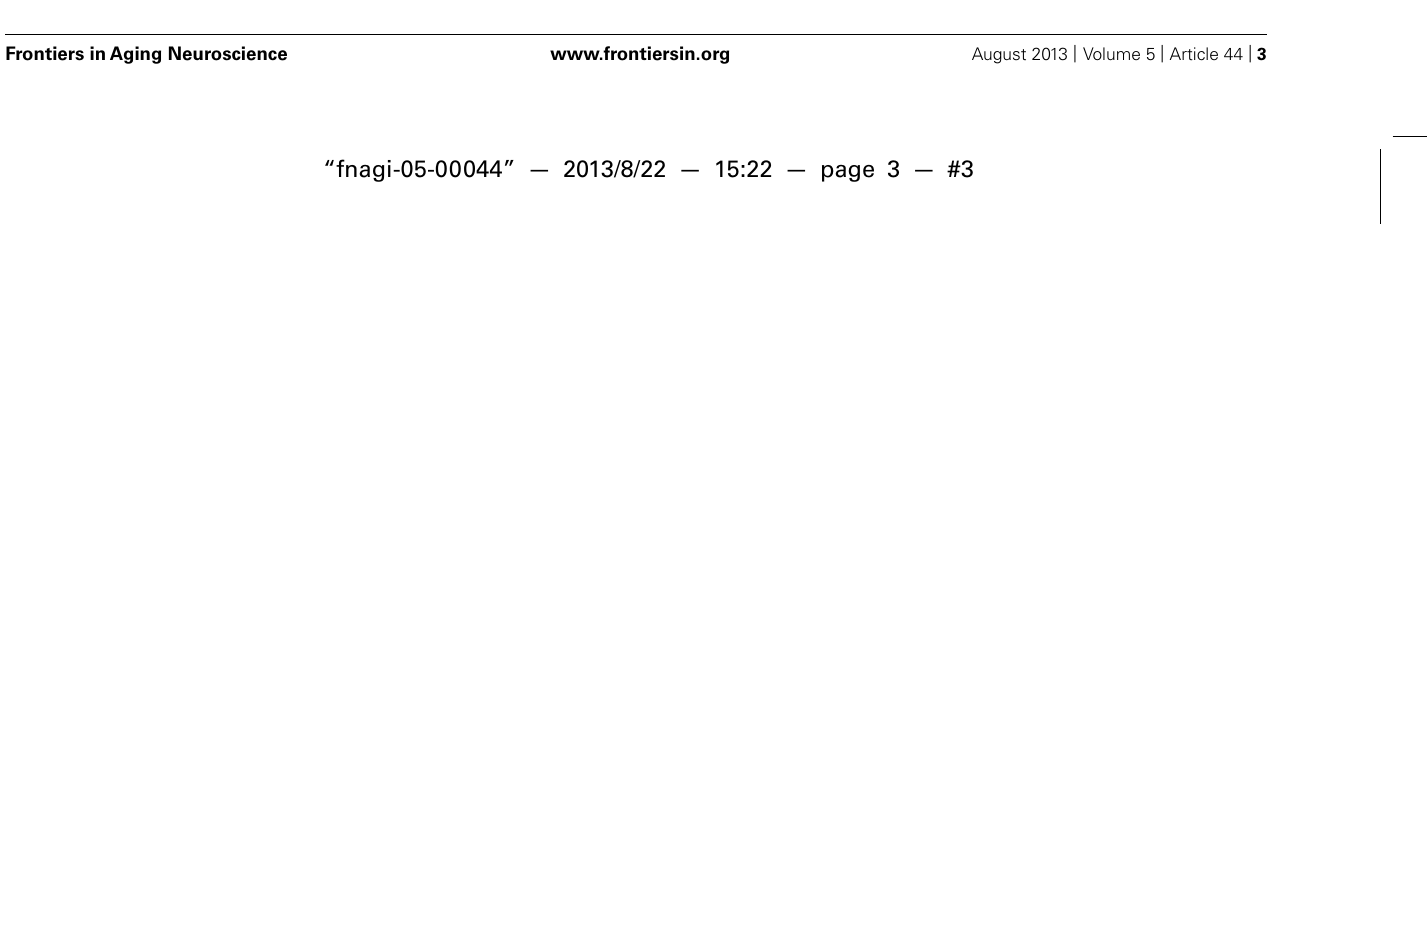
ATP-binding (N-domain) domains; and the motifs and sequences required for their localization and trafficking.The cylindrical regions labeled 1-8 represent the transmembrane